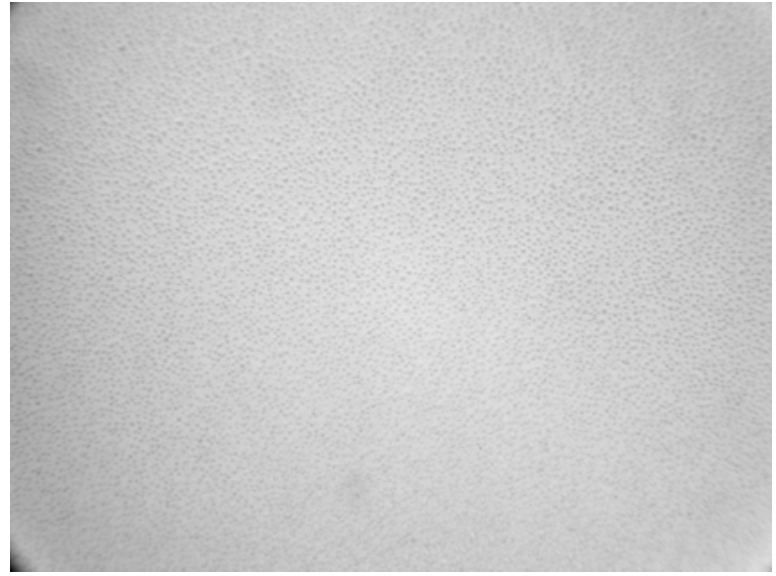
Figure 5. WSi–WSiN–Pt metallization after 100 h of annealing at 500 °C in air (magnification 500×).